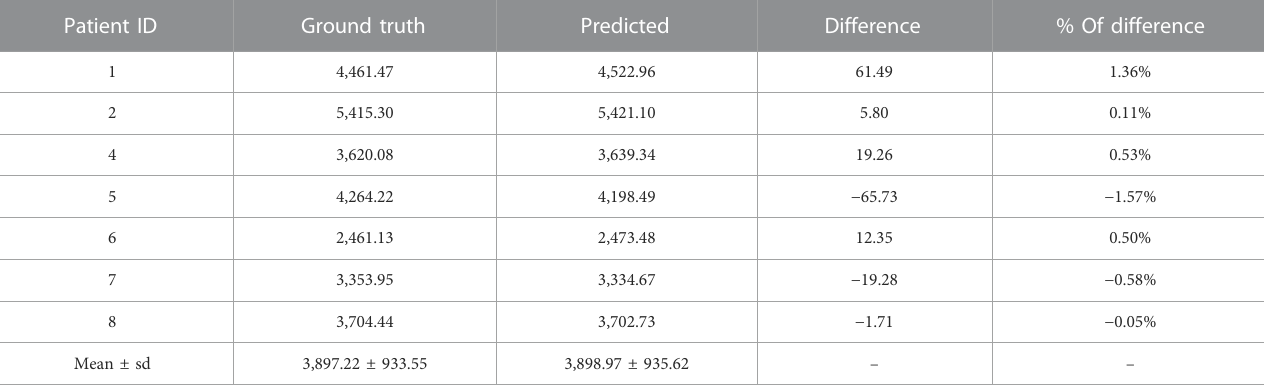
TABLE 4 Accuracy of the subcutaneous fat volume calculation on the independent test set.